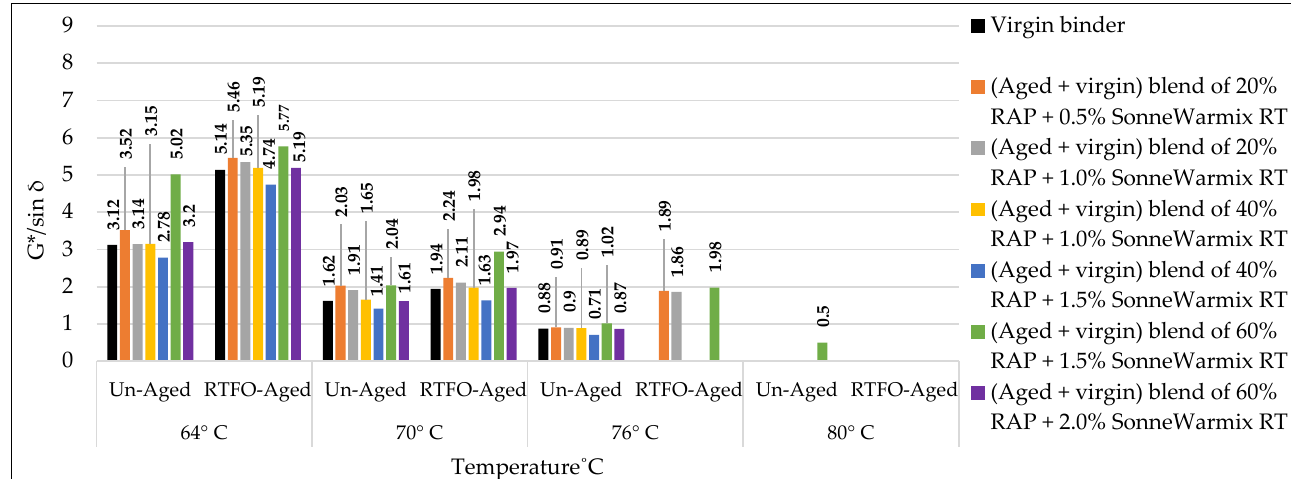
Figure 23. Rutting index (G*/sin δ ) for the aged blends of binders rejuvenated by DSO. 4.